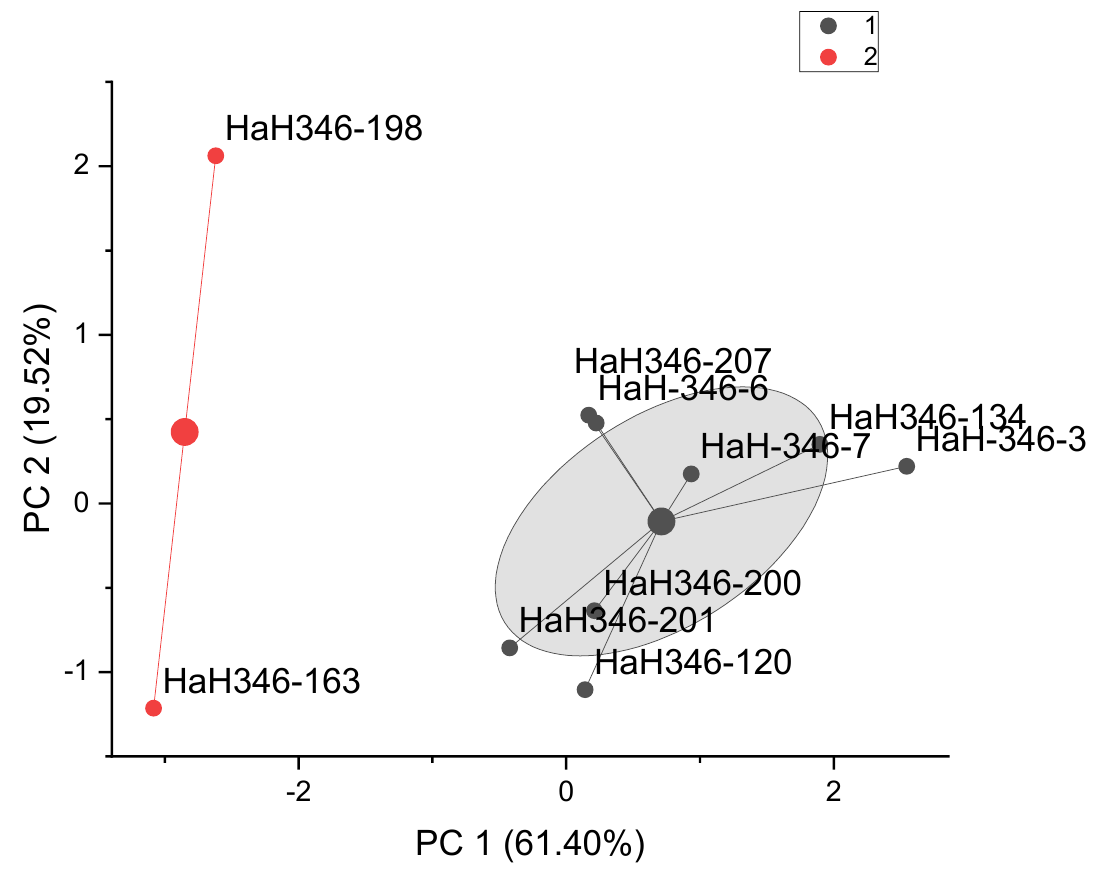
Figure 6. K-means cluster plot: PC2 (19.52%) in function of PC1 (61.40%).